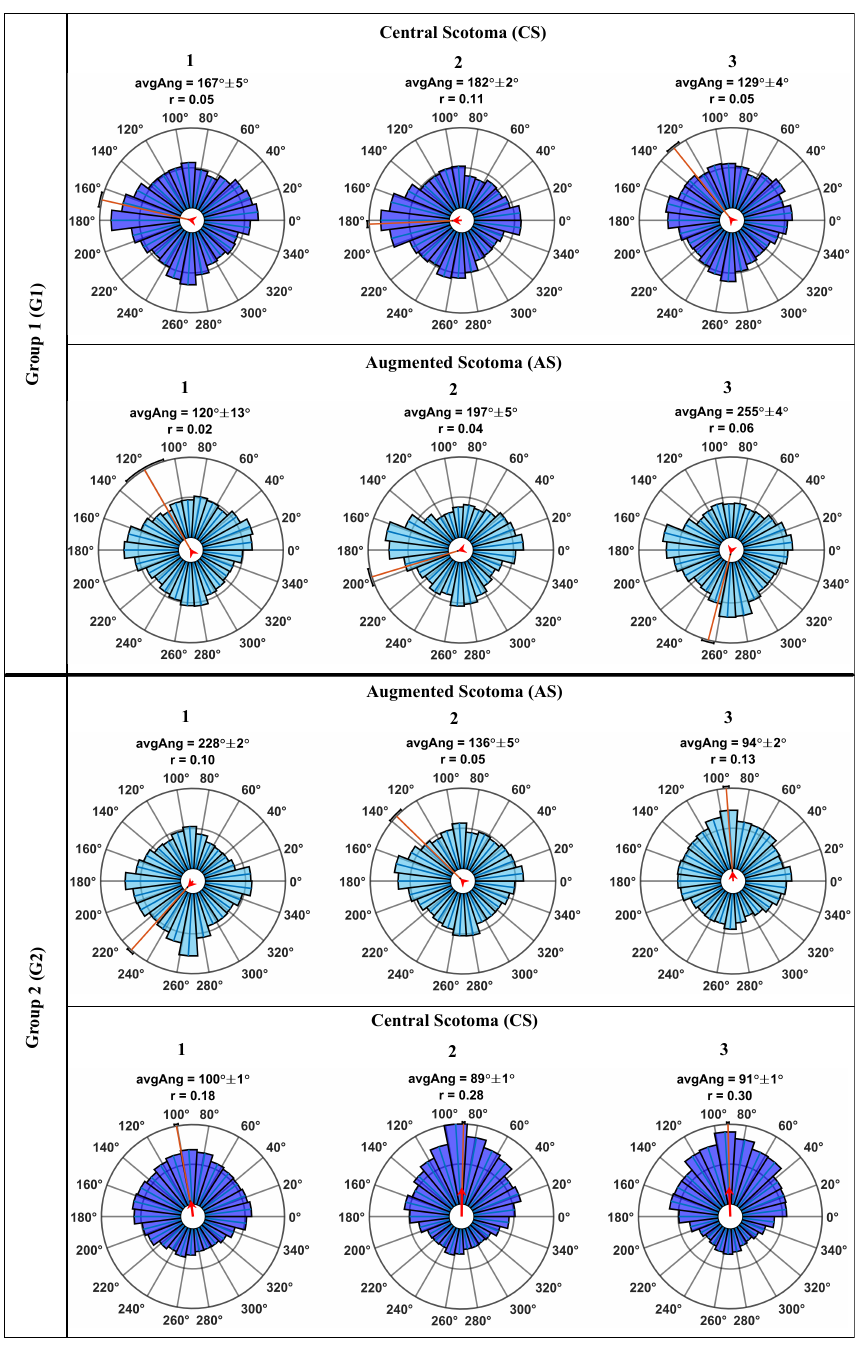
Figure 10. Polar histograms of gaze direction in respect to target for group 1 ( G1 ) and group 2 ( G2 ) across the blocks (1, 2, and 3). Above each polar histogram, the mean resultant length (r) and the average angle (avgAng) with the corresponding SD of gaze-target direction are represented. The long red line represents the average angle, the black bold semicircle at the end of the red line indicates the SD. The red arrow overlapped on top of the long red line is the mean resultant